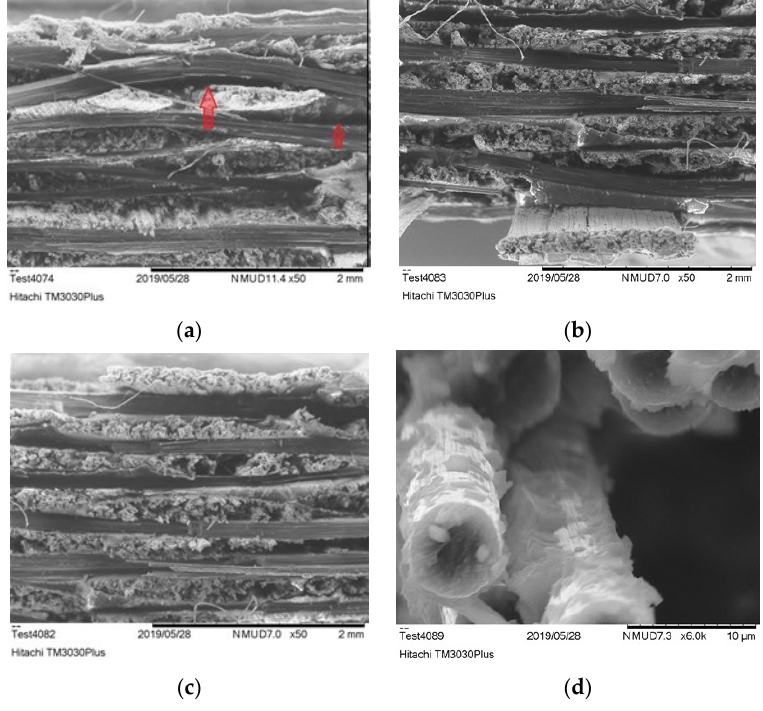
Figure 8. SEM fracture analysis: ( a ) Untreated fabric CFRP ( b ) PMAA-treated fabric CFRP ( c ) APP- treated fabric CFRP ( d ) Epoxy resin bonded on CF after APP